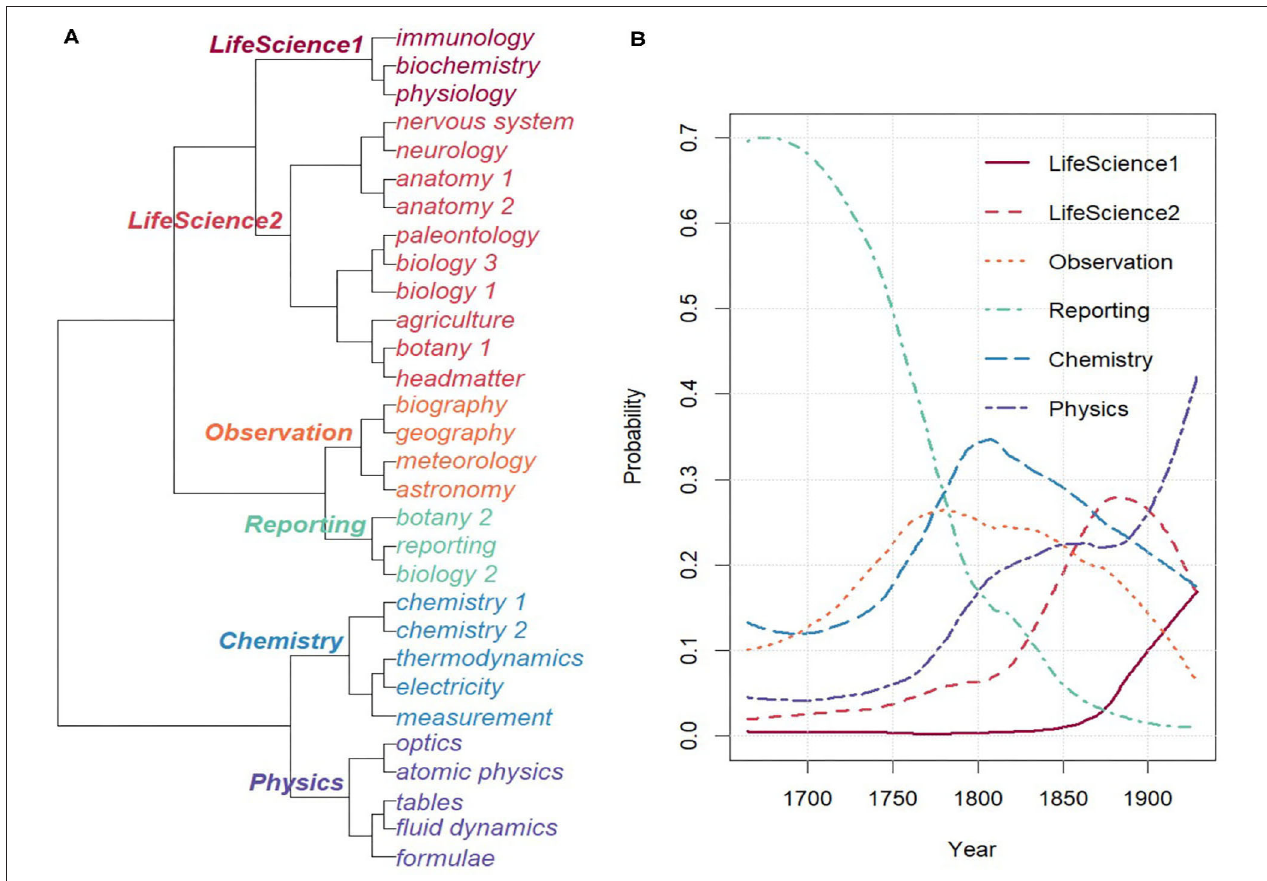
FIGURE 5 | Overview on topics. (A) Topic hierarchy. (B) Combined topics over time.